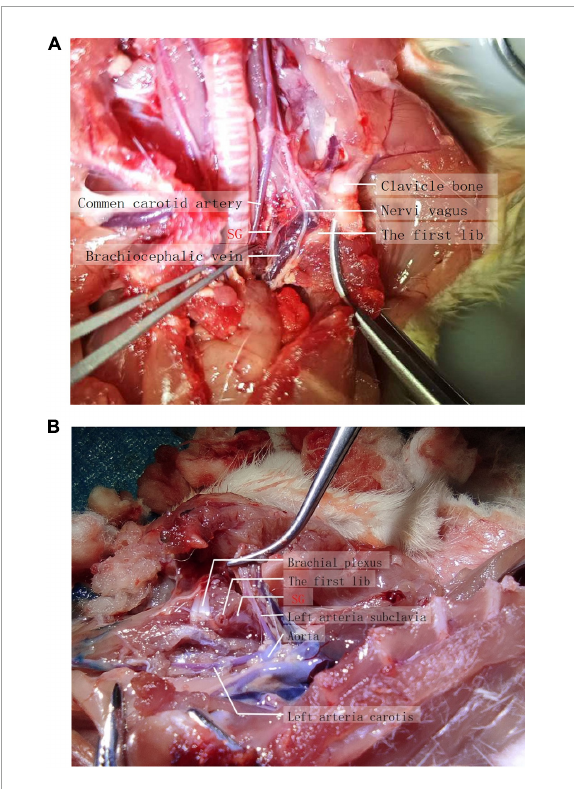
FIGURE1 (A,B) Exact anatomical location of the stellate ganglion.